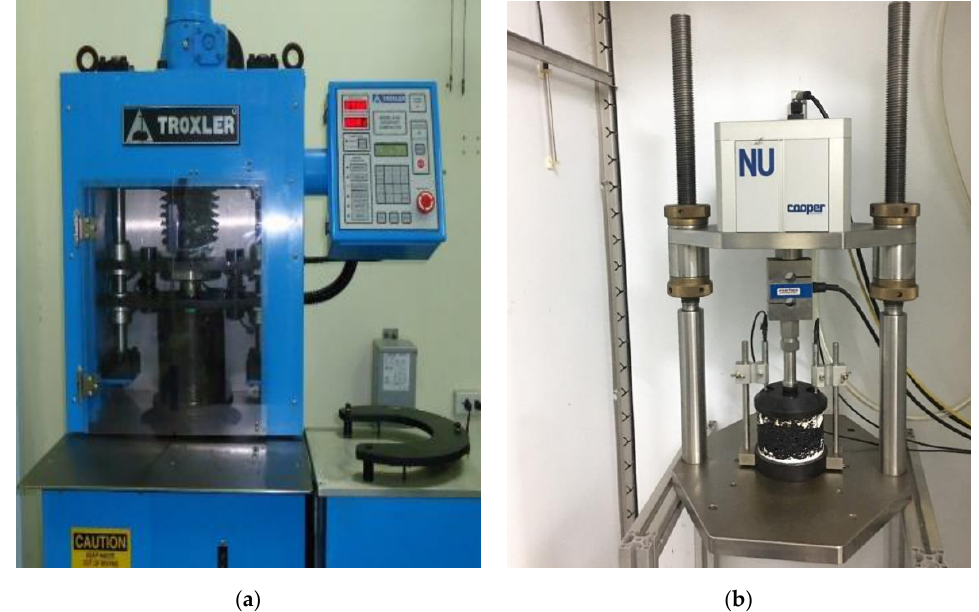
Figure 3. The SMA samples preparation and testing: ( a ) Gyratory Compactor machine, ( b ) CRT NU-14 machine .